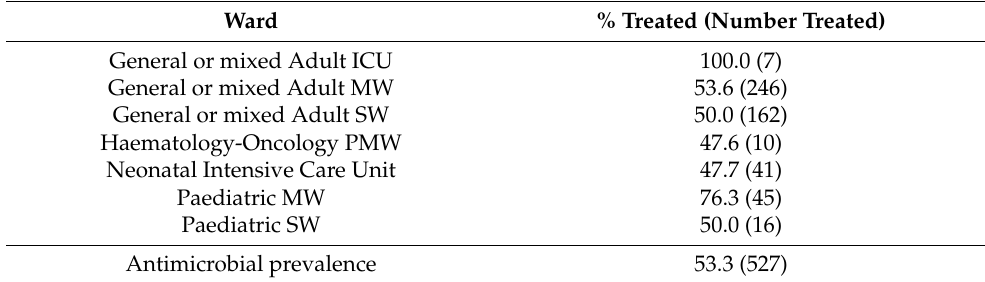
Table 1. Antimicrobial prevalence by ward type.